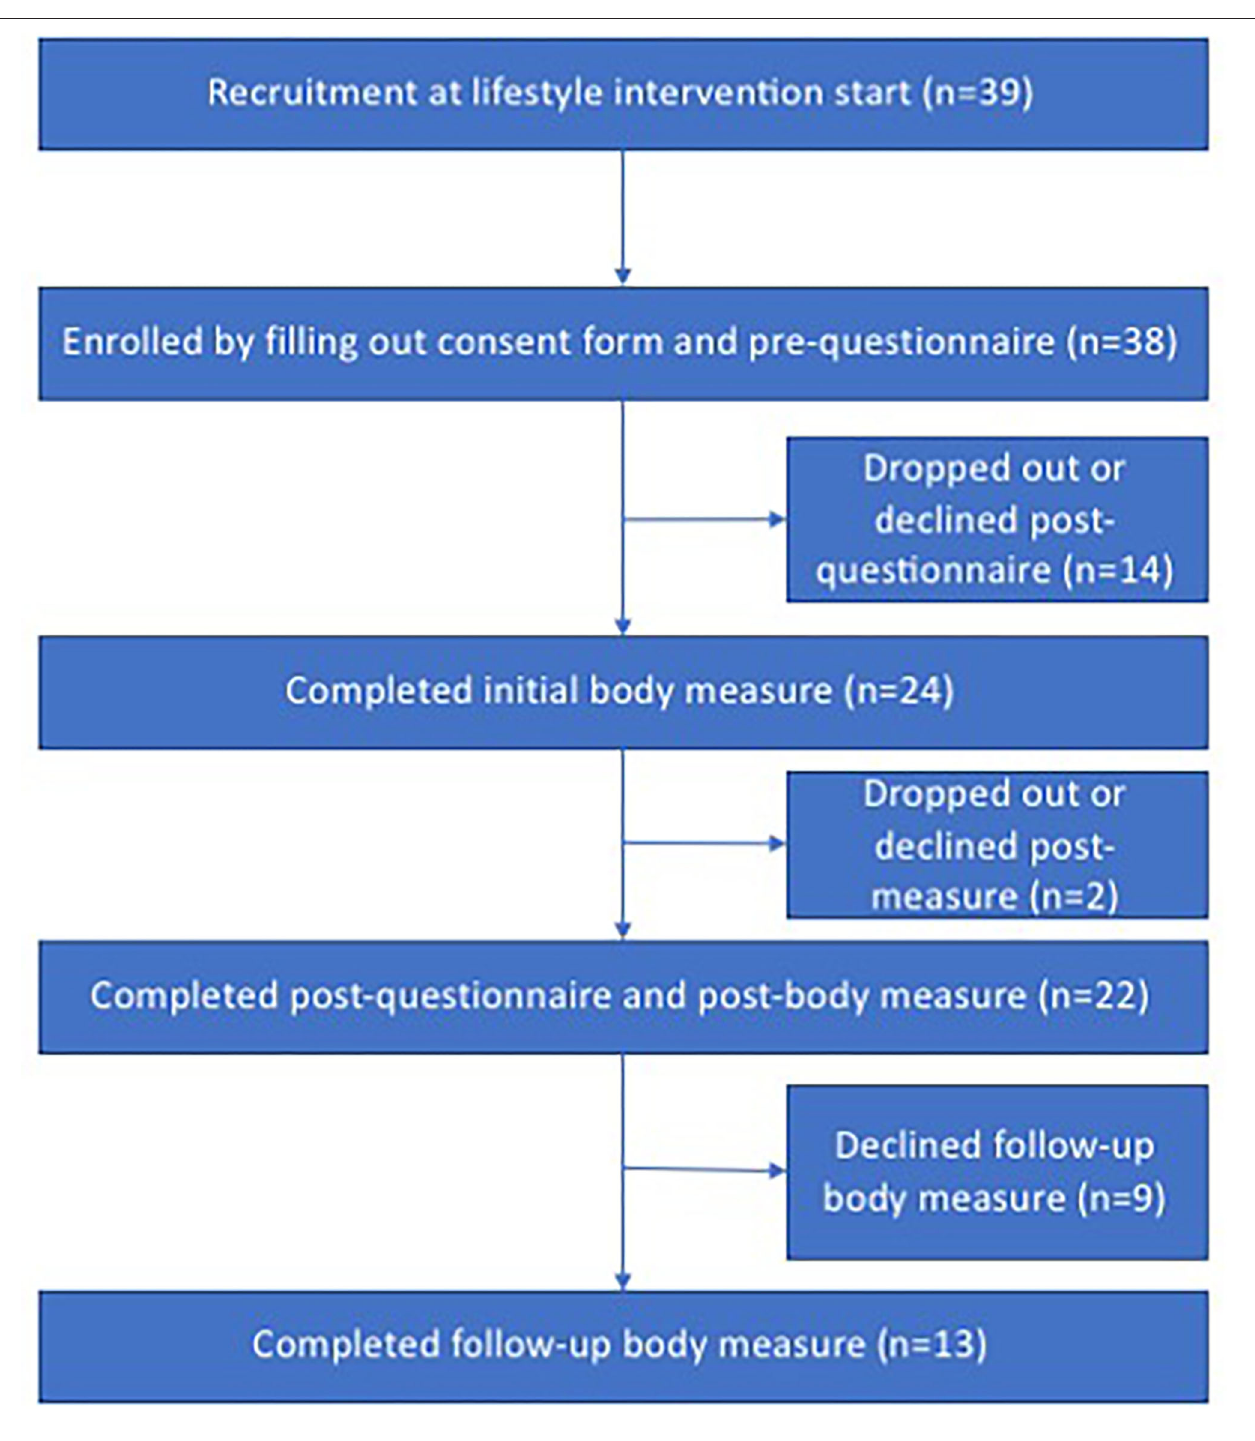
FIGURE 1 | Flowchart recruitment for quantitative data